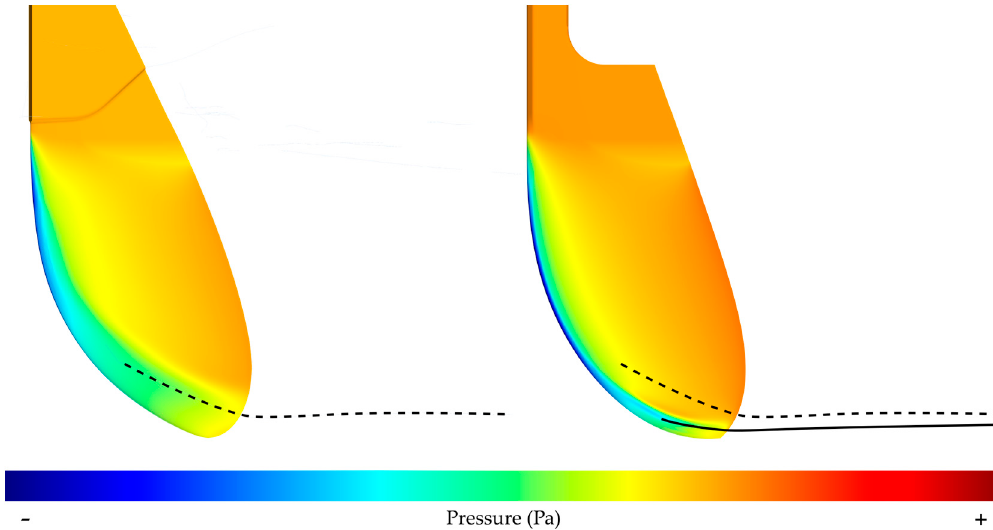
Figure 1. Suction side pressure distributions for the reference rudder ( left ) and the improved rudder ( right ) at 10° rudder angle. Tip vortex cores shown as black